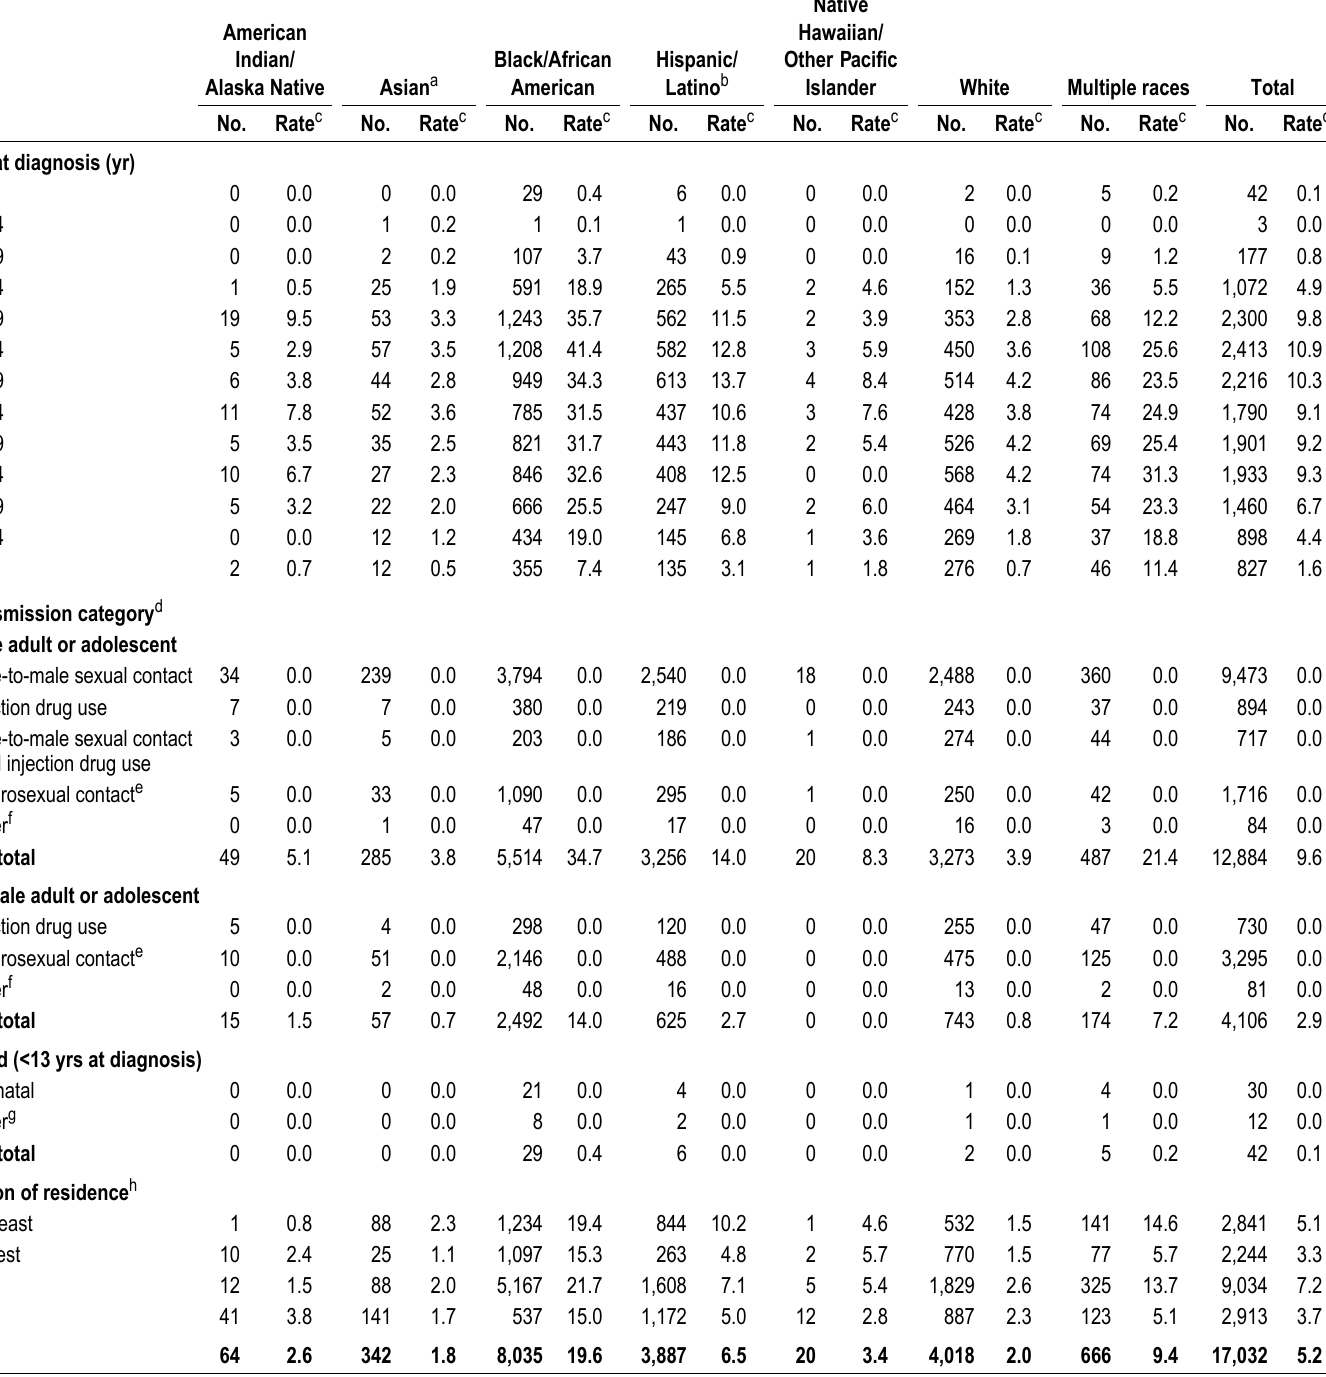
Table 4a. Stage 3 (AIDS), by race/ethnicity and selected characteristics, 2018—United States